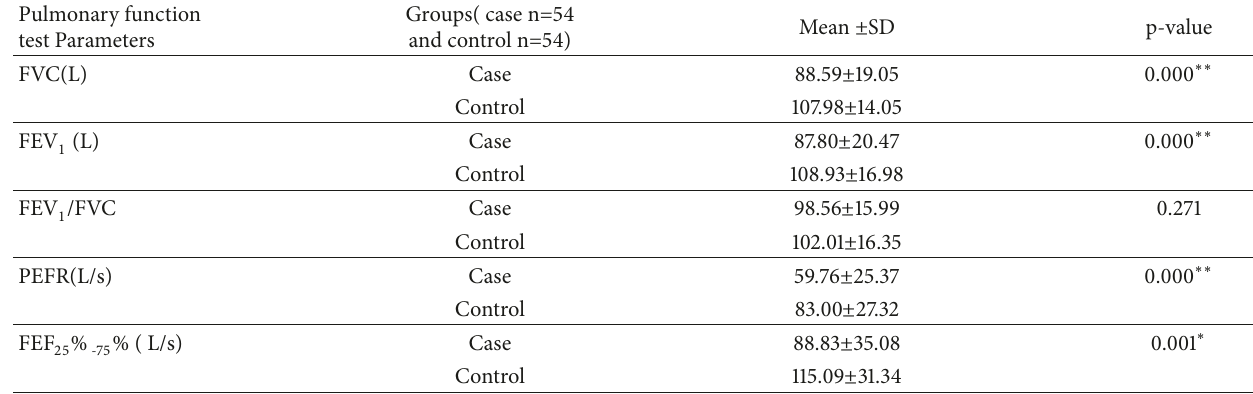
Table 4: Percentage predicted lung function tests of exposed and control groups. Pulmonary